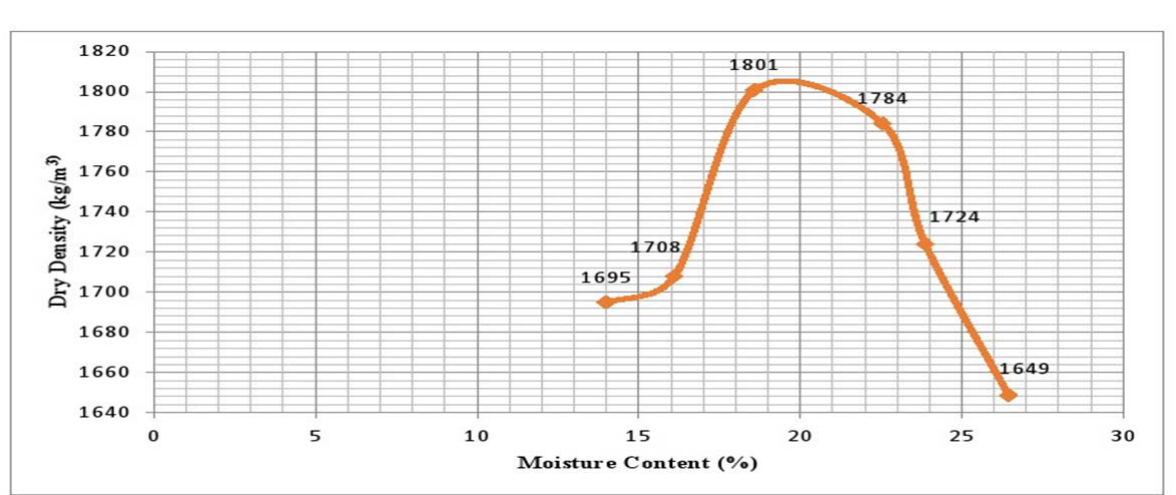
Figure 1. Compaction curve of the lateritic soil in its natural form.